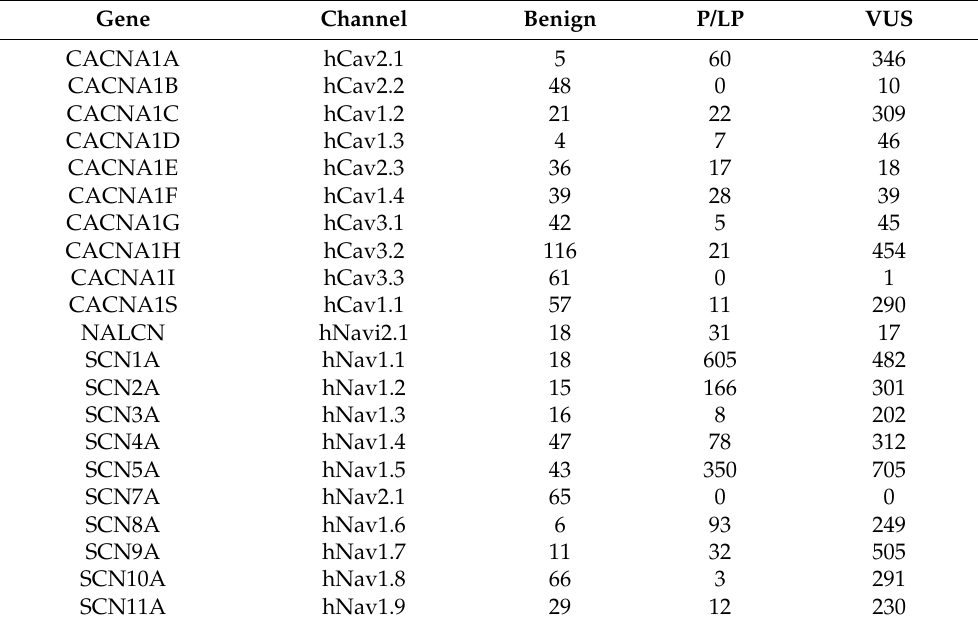
Table 1. Number of missense variants in the human Cav1.2 and its